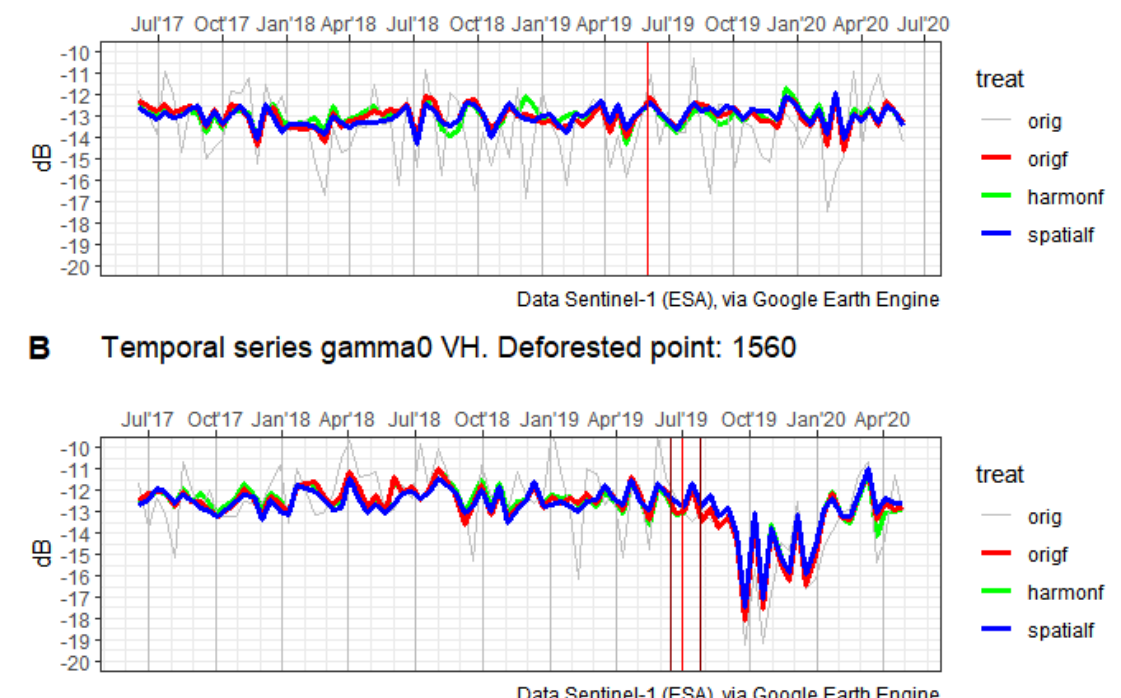
Figure 5. Example of extracted ( A ) forest and ( B ) deforested time series. Only VH two-year collections are showed. The red thin vertical lines represent the location reported before and after dates of deforestation. The red bold line represents the reported date of deforestation.